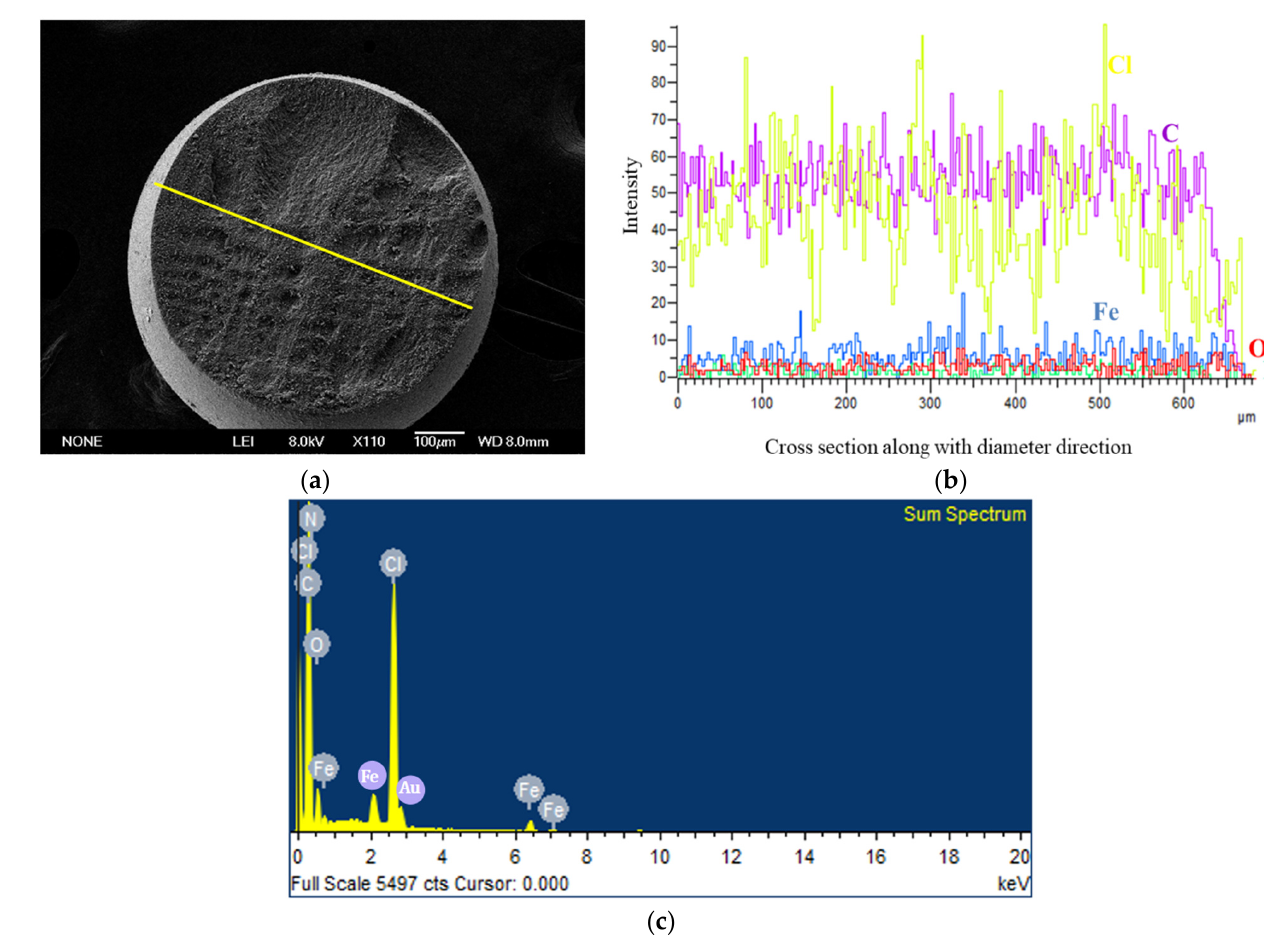
Figure 5. Cross section SEM image ( a ), element distribution diagram ( b ), and EDS spectrum analysis diagram ( c ) of MIL-53/D201.